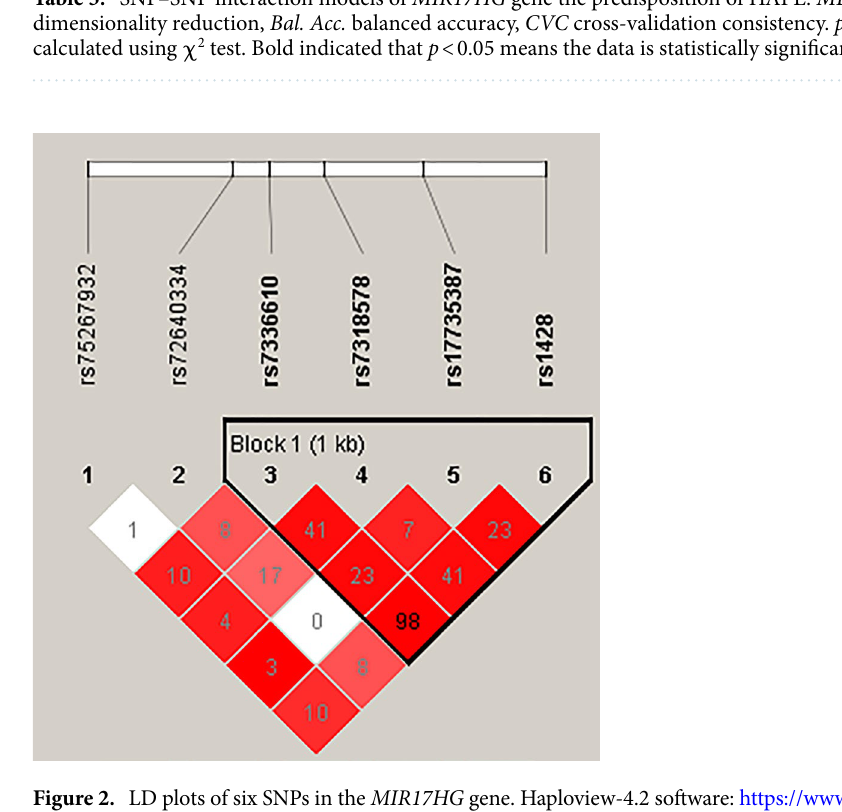
Frequency Without adjusted Adjusted HAPE patients Control OR (95% CI) p OR (95% CI) p